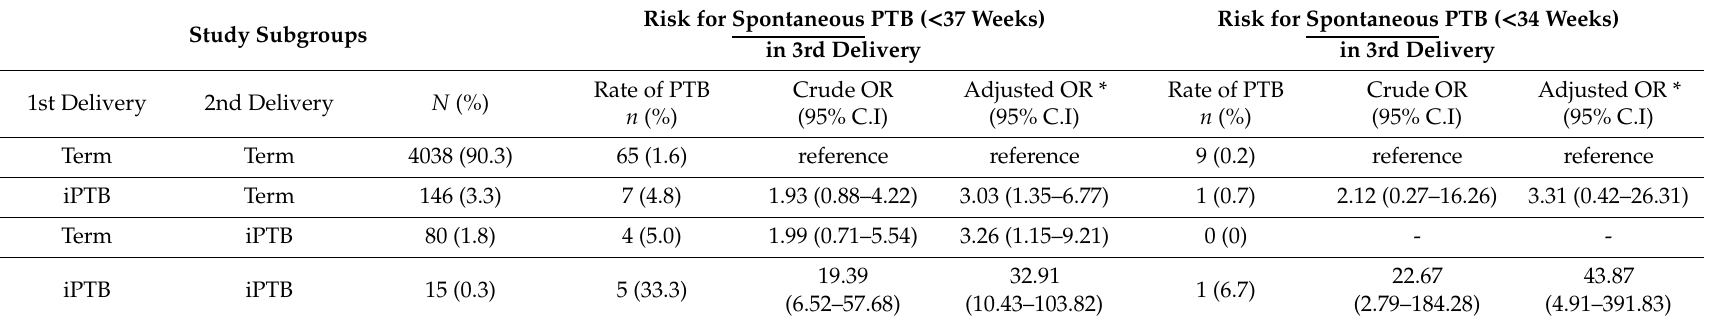
Table 4. The risk for spontaneous preterm birth in the third delivery stratified history of indicated preterm births. Study